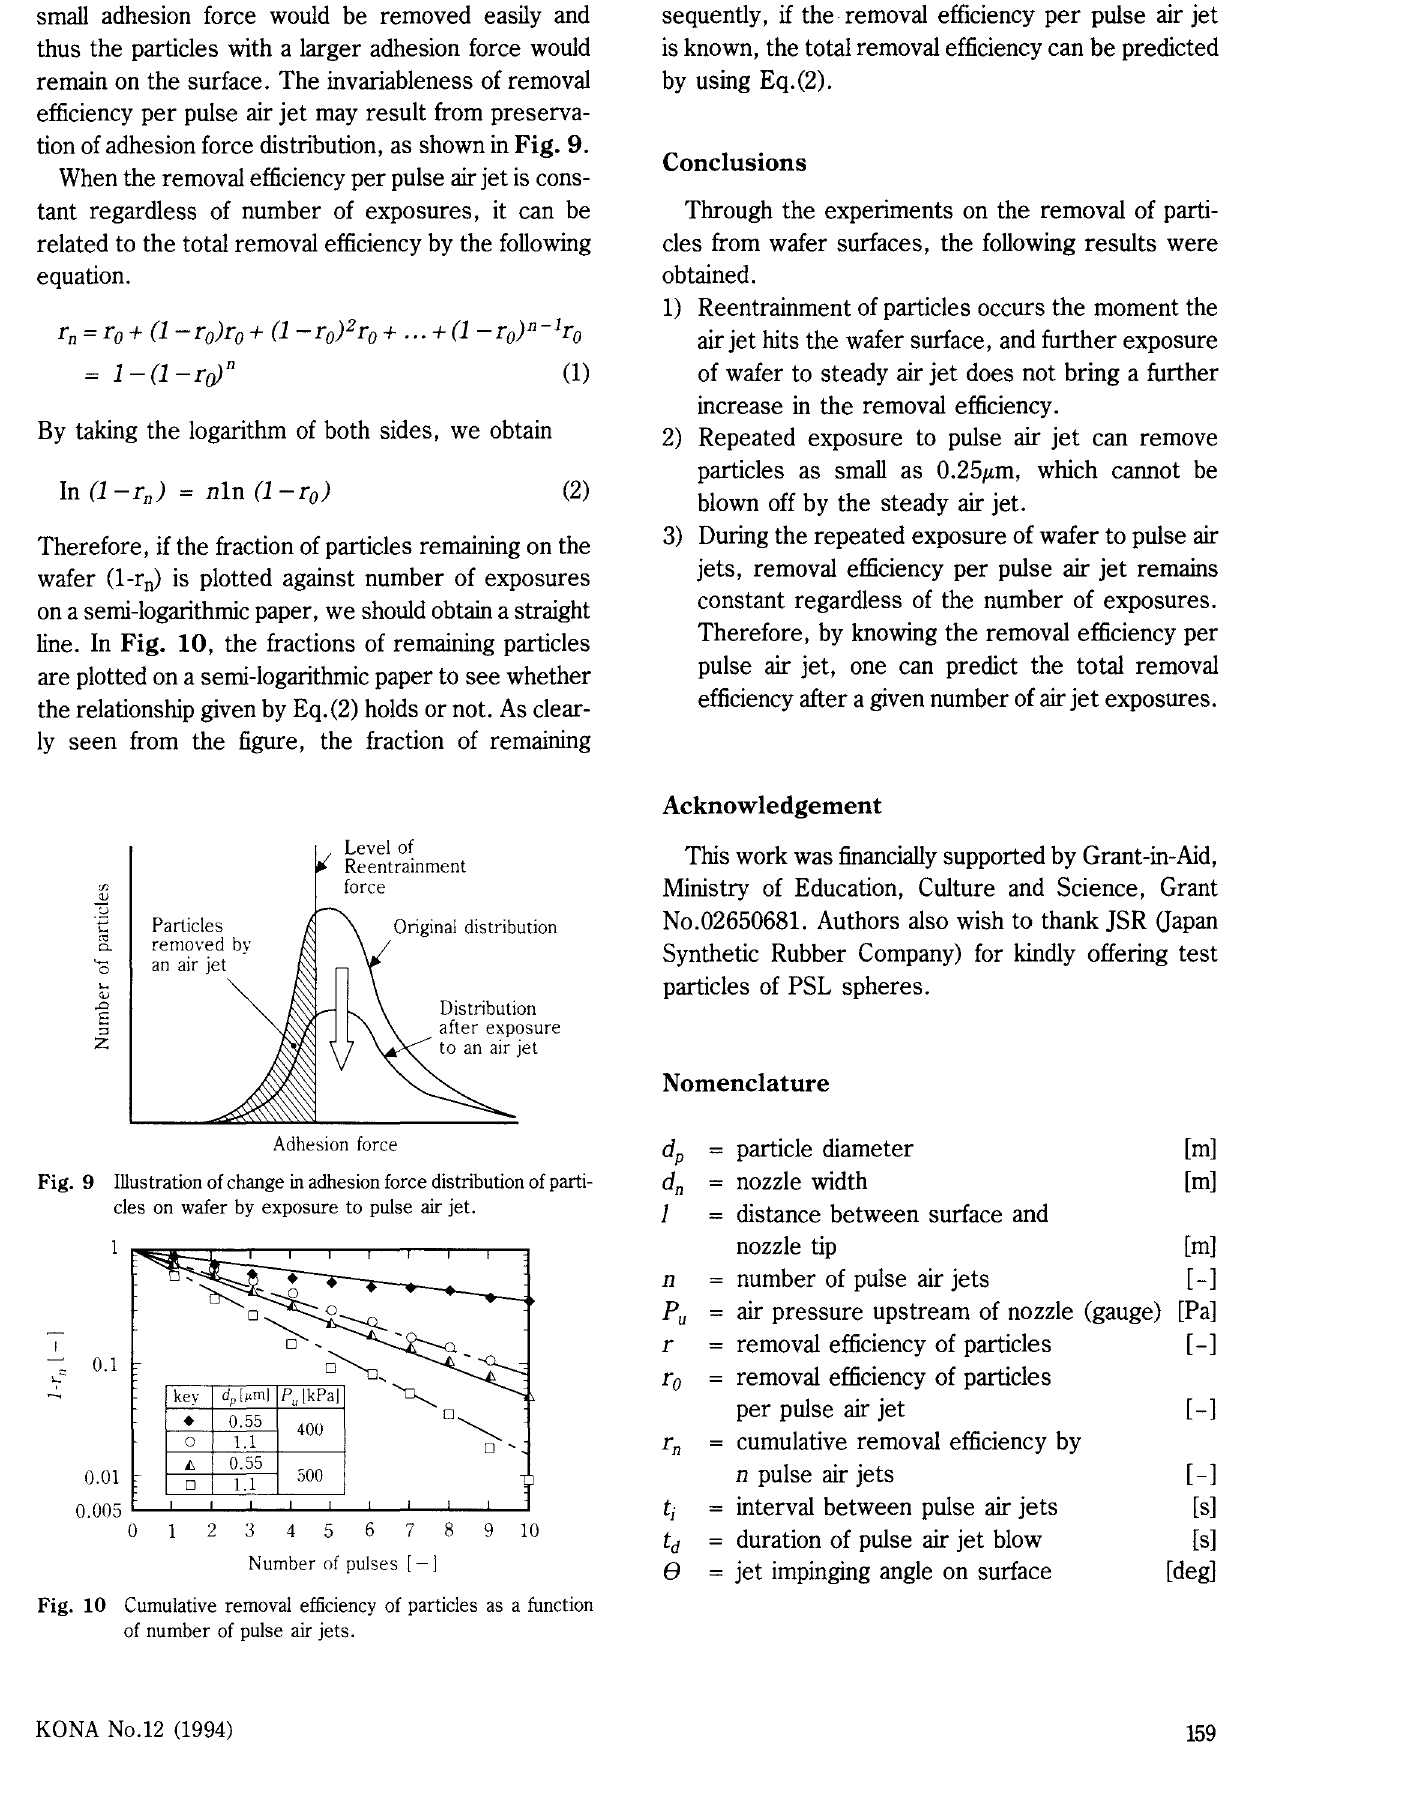
Fig. 10 Cumulative removal efficiency of particles as a function of number of pulse air